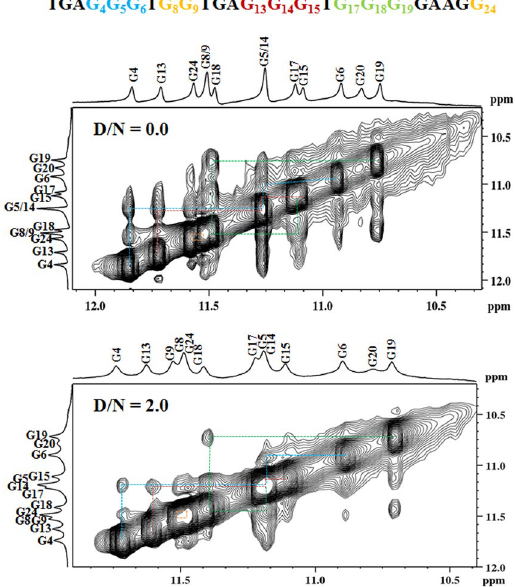
Figure 7. Portion of NOESY spectrum of Quercetin – Pu24T complex. Portion of NOESYspectrum of showing NH-NH NOEs between adjacent G-tetrads at 298 K at D/N ratio = 0.0 (top) and 2.0 (bottom). (Dashed lines shows the sequential connectivity).